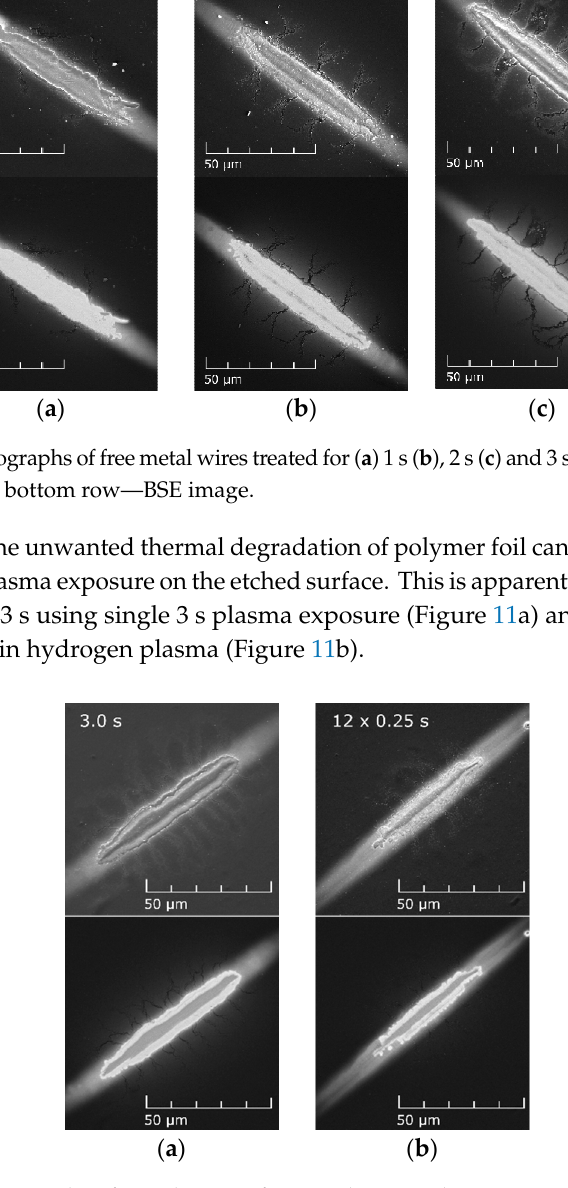
Figure 11. SEM micrographs of metal wires after 3 s plasma etching in pure H 2 plasma at distance H = 0.6 mm for single 3 s plasma exposure ( a ) and the multiple very short exposures (12 × 0.25 s) ( b ). Top row—SE image; bottom row—BSE image.